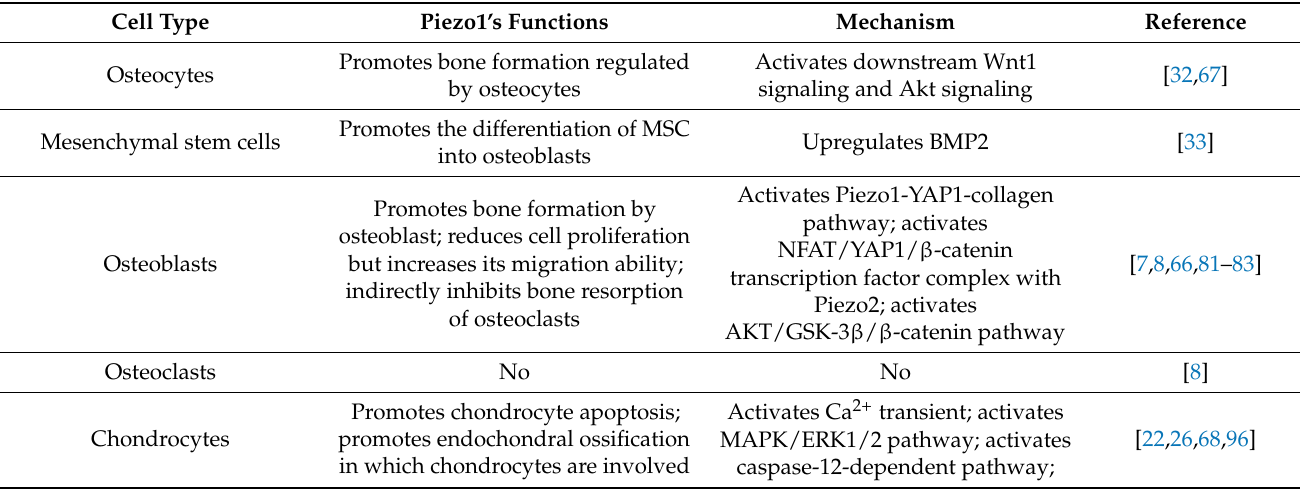
Table 2. Functions and mechanism of Piezo1 in bone